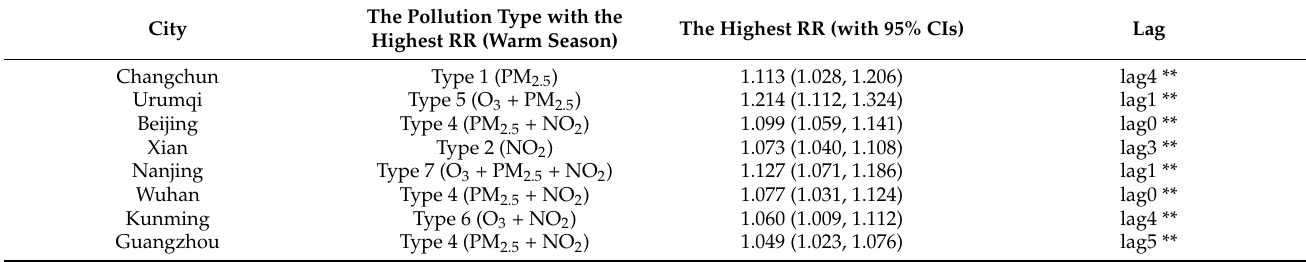
Table 5. The pollution type with the highest lag of 0–5 days and their corresponding risk values and lag days in 8 cities. Pollutants at high levels are listed in parentheses (Warm Season). ** p <